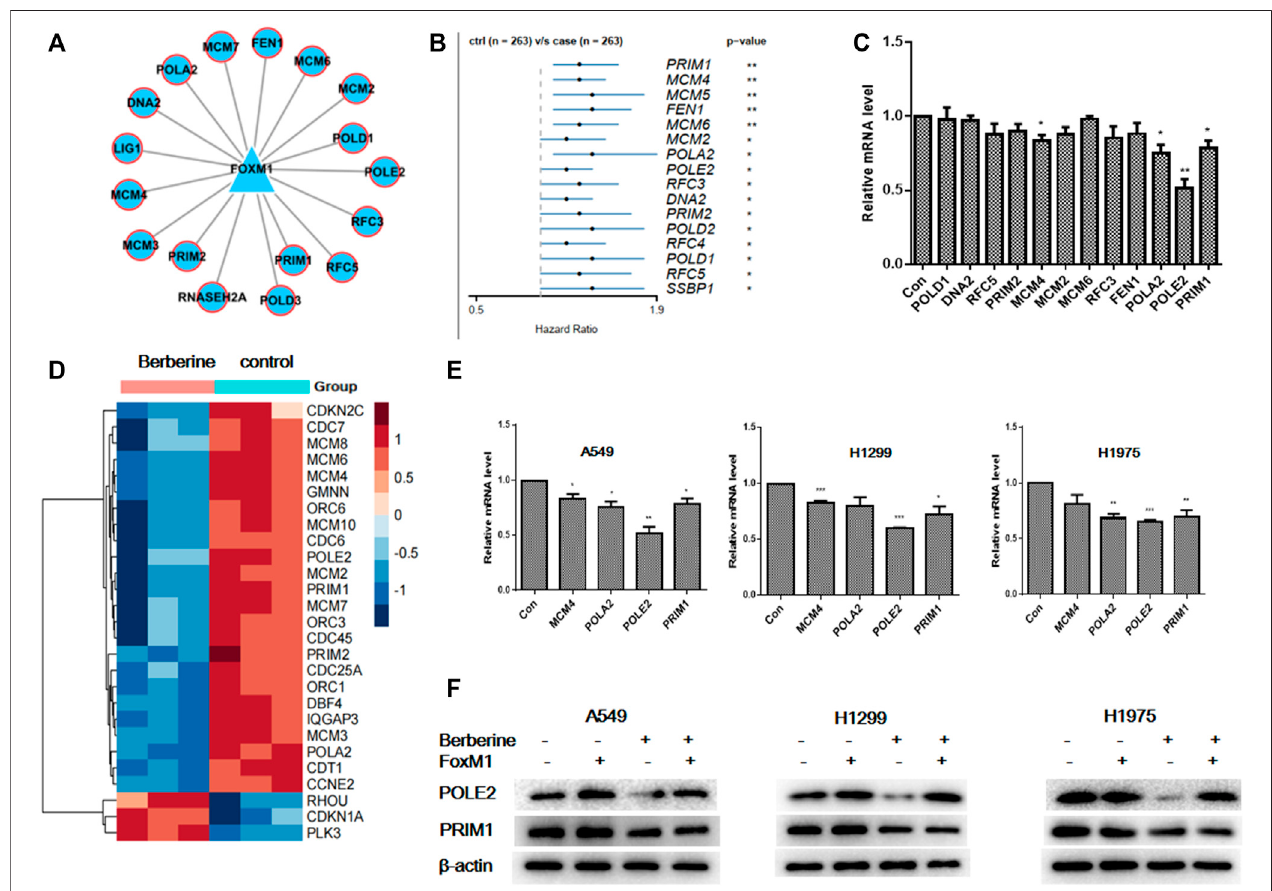
FIGURE 6 | Berberine interfered the expression of survival related genes POLE2 in DNA replication mediated by FOXM1. (A) FOXM1 regulates DNA replication pathway related differential genes. (B) Forest plot of the DNA replication-DEGs RNA-expression pro fi les in univariate Cox proportional hazards analysis in TCGA-LUAD cohort. DNA replication-DEGs were DEGs in berberine cohort and related to DNA replication pathway. Only those genes met p -value < 0.05 were plotted. (C) We selected common genes both in DNA replication related genes regulated by FOXM1 in A549 cells and DNA replication related survival genes in TCGA, and the expression levels of them in A549 cells were tested by PCR after berberine treatment (90 μ M). * p < 0.05; ** p < 0.01; *** p < 0.001, compared with the control group. (D) The heat map showed that MCM4, POLA2, POLE2 and PRIM1 were involved in G1/S transition of mitotic Cell cycle and DNA replication, while berberine could signi fi cantly down regulate their expression, especially on POLE2 and PRIM1. (E) Berberine regulated MCM4, POLA2, POLE2 and PRIM1expression by PCR in both A549, H1299 and H1975 cells. (F) After overexpression of FOXM1 or treatment with berberine, the expression levels of POLE2 and PRIM1 were detected by WB in A549, H1299 and H1975